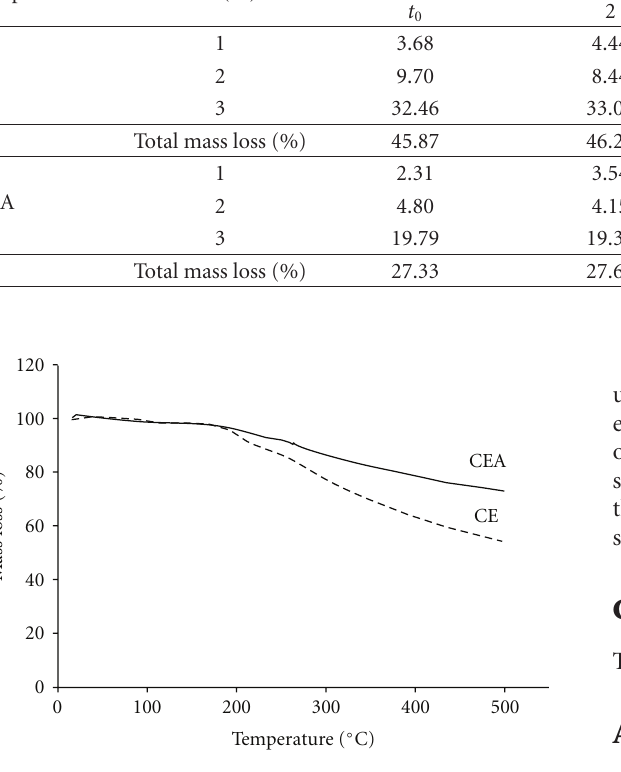
Figure 5: Thermogravimetry curves for the (dashed line) crude extract (CE) and (staked line) crude extract + colloidal silicon dioxide (CEA) of Guazuma ulmifolia at time